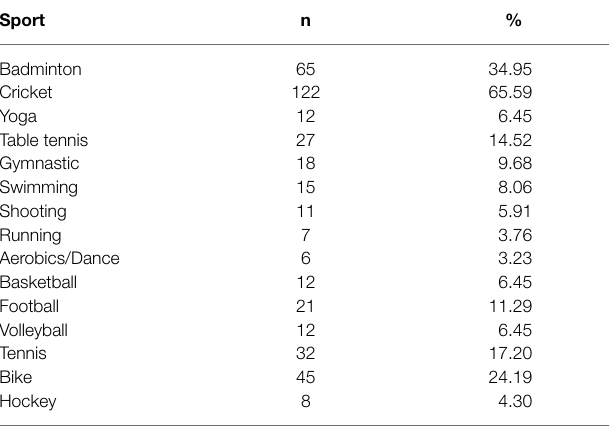
TABLE 3 | Sports played by Pakistani women.